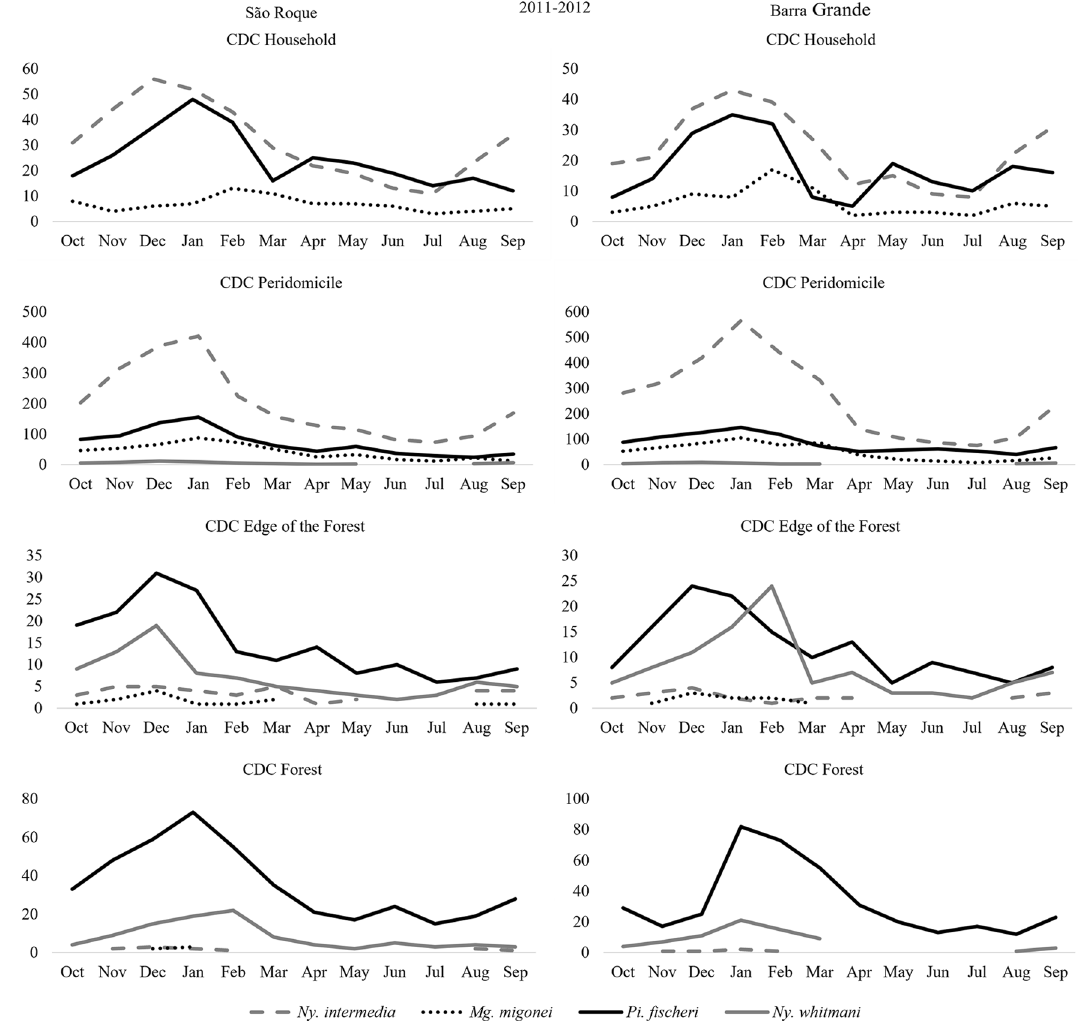
Figure 6. Monthly Frequency of Sand flies: Nyssomyia intermedia , Migonemyia migonei , Pintomyia fischeri and Nyssomyia whitmani , captured in the CDC light traps (household, peridomicile, edge of the forest and in the forest), from October 2011 to September 2012, in the neighborhoods of São Roque and Barra Grande, Municipality of Paraty, State of Rio de Janeiro, Condino et al. 36 , when studying the southwestern region of the state of São Paulo, observed that Ny. inter- media and Ny. whitmani had the highest frequencies during the months of May, September, and December with temperatures ranging from 21 to 25.7 °C and rainfall between 66.7 and 195.1 mm. In June, the lowest frequency of sand flies was observed, which then increased until a maximum peak in September. Temperature data and rainfall index were not correlated with the density of specimens, especially as the study was carried out over only one year. In this study, the opposite was observed for Ny. intermedia and Ny. whitmani in the month of May, one of the months with the lowest density. In the city of Petrópolis, state of Rio de Janeiro, Souza et al. 24 observed a prevalence of Ny. intermedia and Ny. whitmani, with the latter species prevailing around the residence. Migonemyia migonei and Pi. fischeri were also present but to a lesser extent. In the forest, Ny. whitmani was more abundant, followed by Pi. fischeri , while Ny. intermedia was found at lower abundances. However, Ny. intermedia and Pi. fischeri were present during every month of the year. The authors also found a significant correlation between the number of sand flies and environmental changes such as temperature, relative humidity, and rainfall. The same was observed, in this study, in the forest with Ny. intermedia , however, in this environment the number of Pi. fischeri specimens was higher than that of Ny. whitmani . In the north of Espírito Santo, Virgens et al. 37 observed that Ny. intermedia was present in almost every month of the study period, with peaks in the warmer and wetter months. The authors highlighted that the low numbers of this species were recorded during and after high rainfall periods, suggesting that heavy rain is unfavorable for the development of immature forms, as breeding sites in altered habitats suffered a greater impact because of extreme weather conditions.